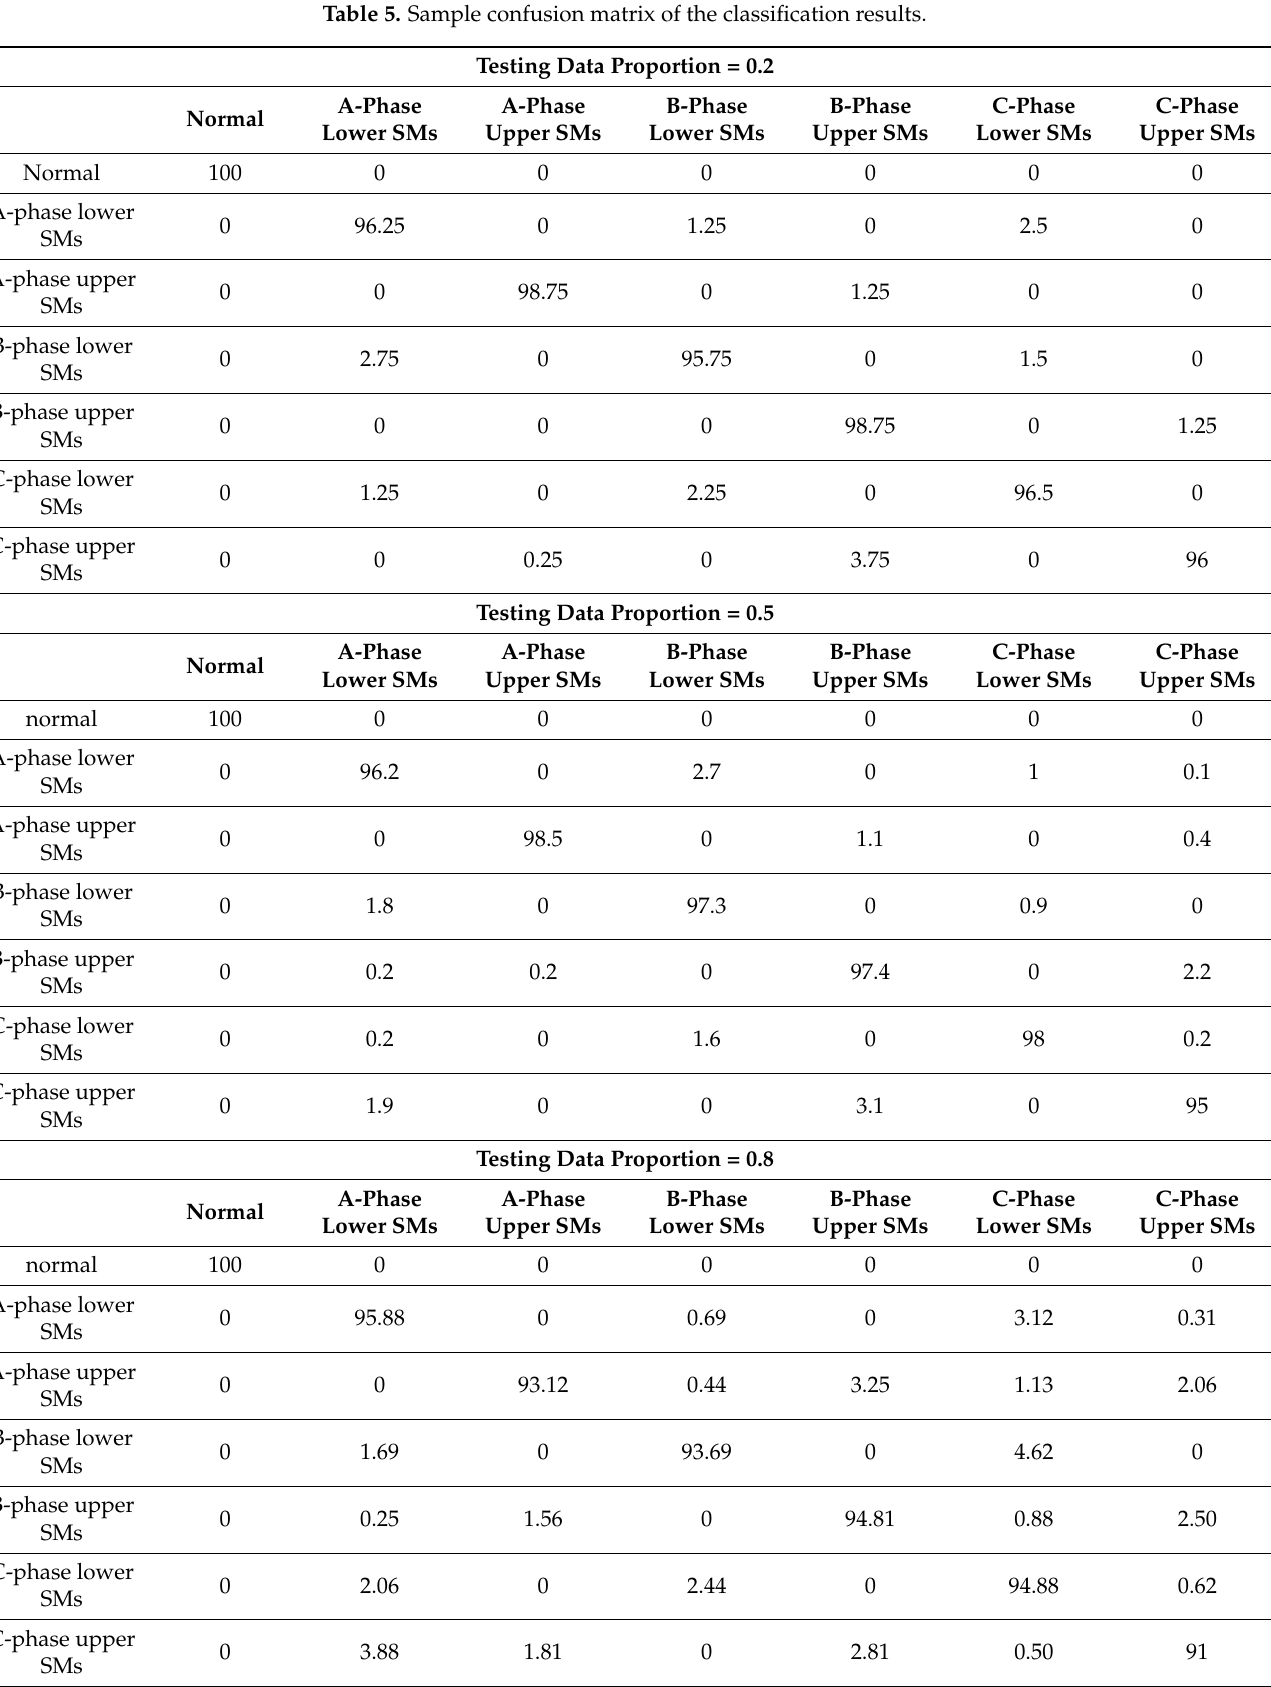
Table 5. Sample confusion matrix of the classification